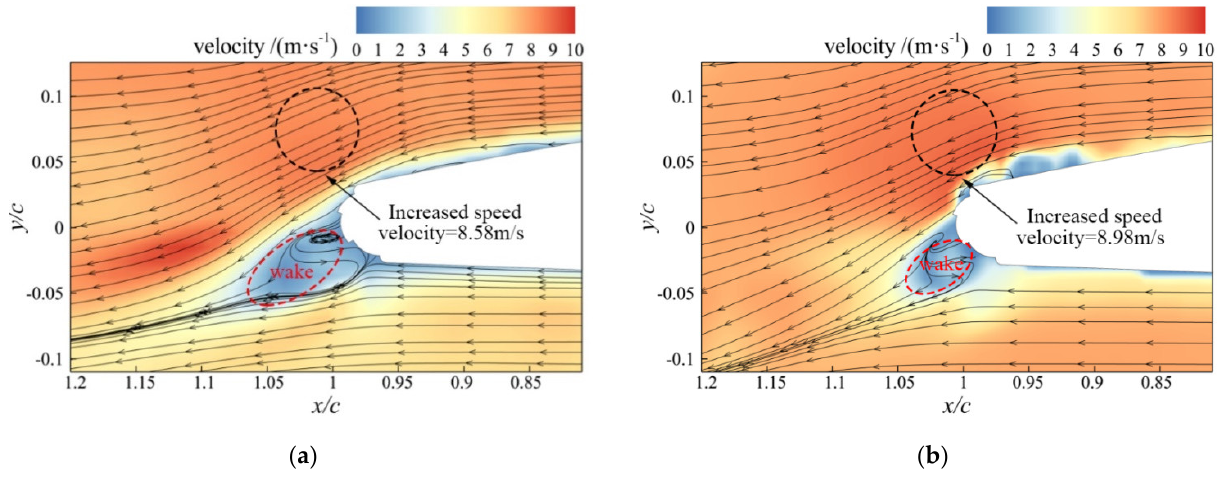
Figure 17. Comparison of velocity cloud and streamline diagrams at different blowing ratios ( U ∞ = 8 m/s, AoA = 0°). ( a ) 1:1:1 Blowing ratio. ( b ) 3:1:2 Blowing ratio.